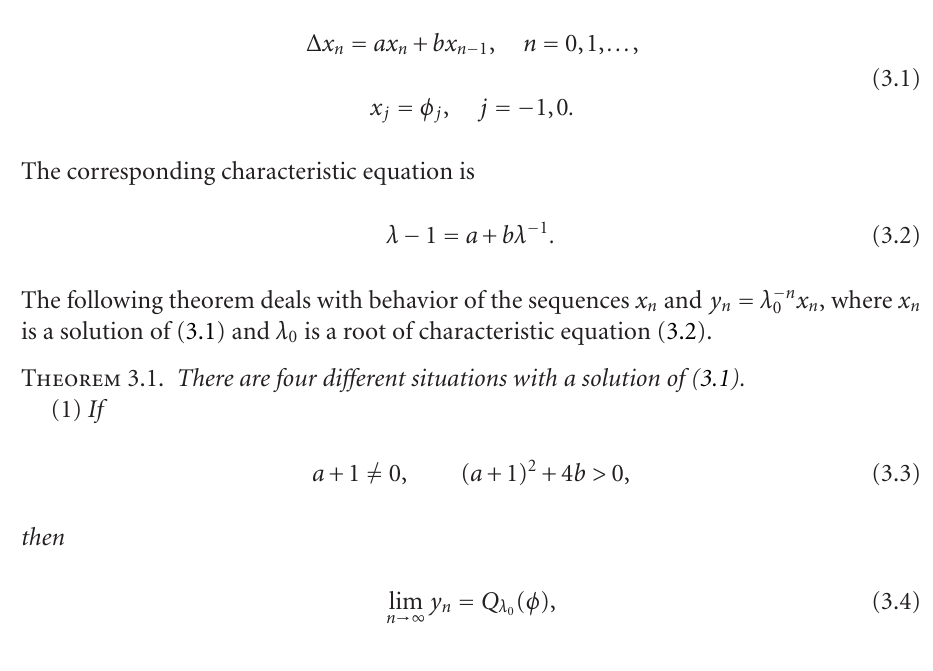
On Figure 2.1 stability regions for (2.8) are shown constructed by conditions (2.9) (region AECF), (2.10) (region ABCD), (2.11) (region GCD), and (2.12) (region